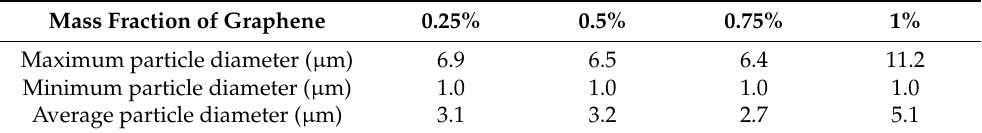
Table 2. Graphene-agglomerated particle diameter in micrograph of a glycerol–graphene coupling agent. Mass Fraction of Graphene Figure 5. Micrograph of the glycerol–graphene coupling agent. ( a ) graphene mass fraction is 0.25%, ( b ) graphene mass fraction is 0.5%, ( c ) graphene mass fraction is 0.75%, ( d ) graphene mass fraction is 1%.